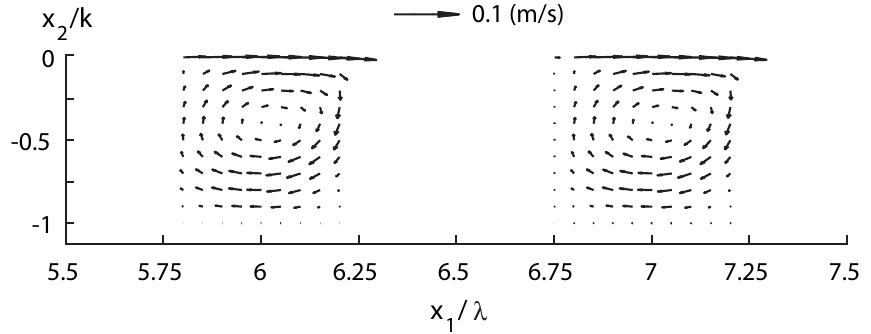
Figure 4. Vectors of predicted mean-flow velocities ( U 1 , U 2 ) in two adjacent cavities for Run 1. The distributions of vectors in each cavity show a major clockwise